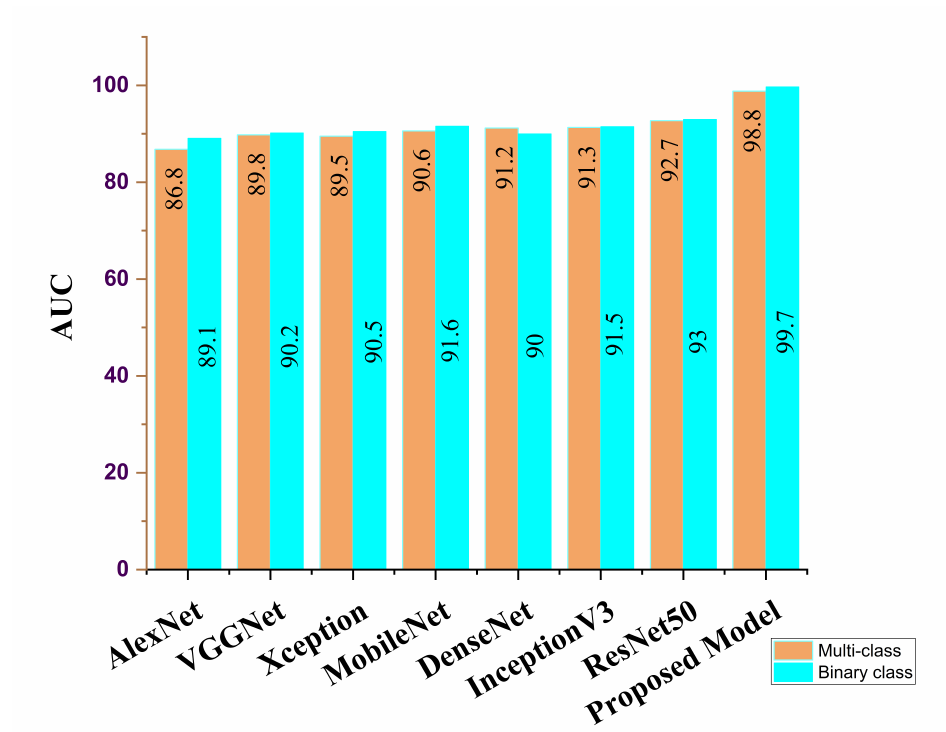
Figure 8. AUC report for our proposed model and selected pre-trained models for binary class and multi-class.